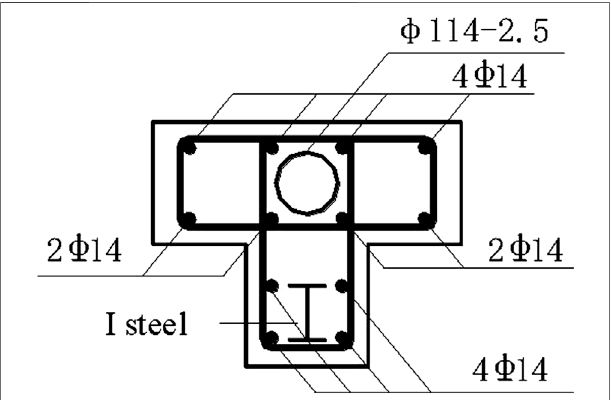
FIGURE 5 | Reinforcement of the beam section of specimens JD-1, JD- 2, and